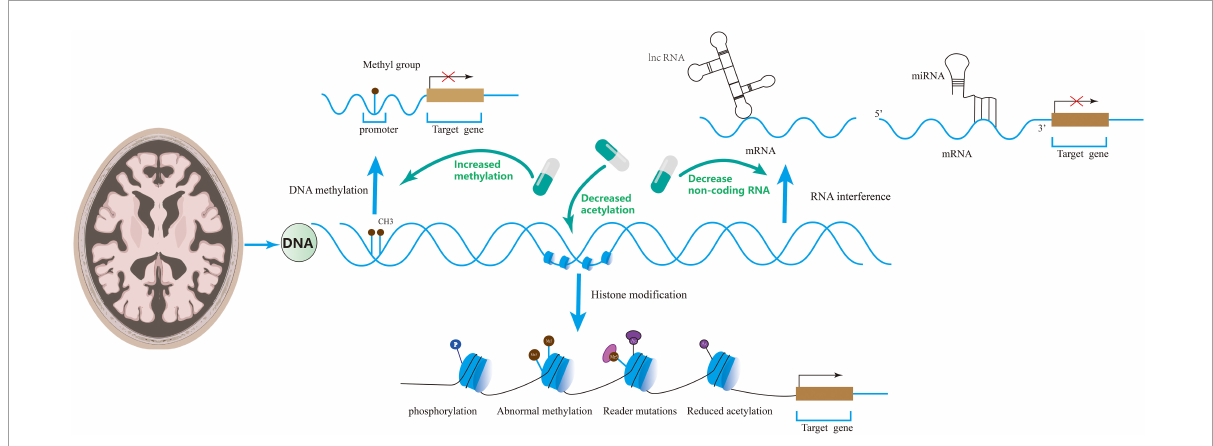
FIGURE2 Epigenetics includes DNA methylation, RNA interference, and histone modifications that regulate synaptic disorders. Drugs can ameliorate synaptic disorders through